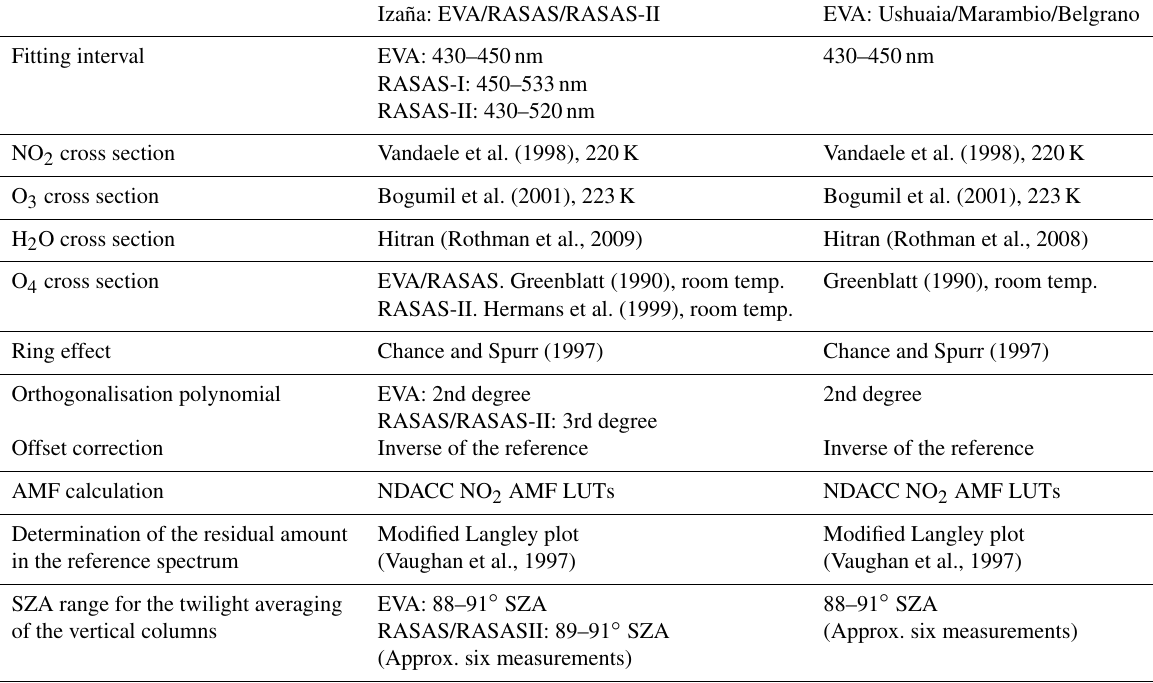
Table 1. DOAS retrieval